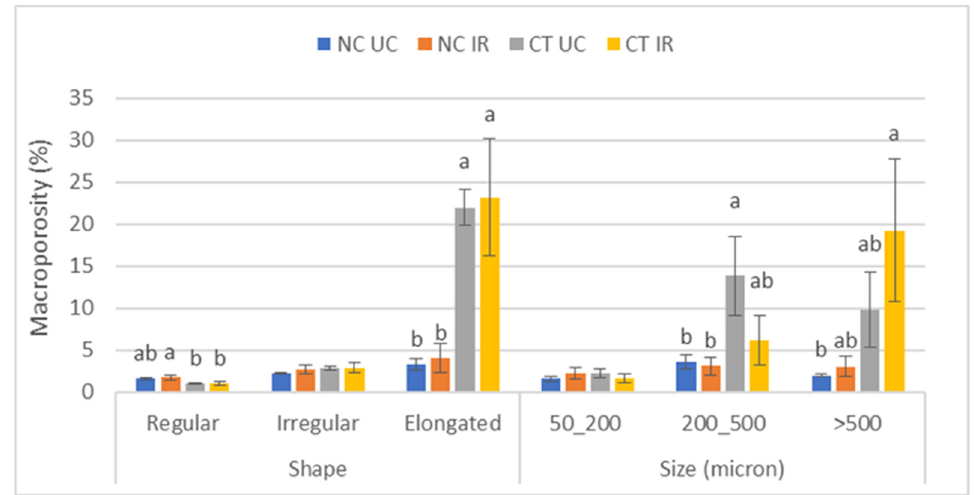
Figure 3. Soil porosity compared in four experimental plots managed by natural grass cover (NC) or conservation tillage (CT) under the canopy (UC) or between the rows (IR). Histograms are means of 6 replicates. Letters on top of bars denote significant differences within the positions and treatments (Duncan’s test; p < 0.05).